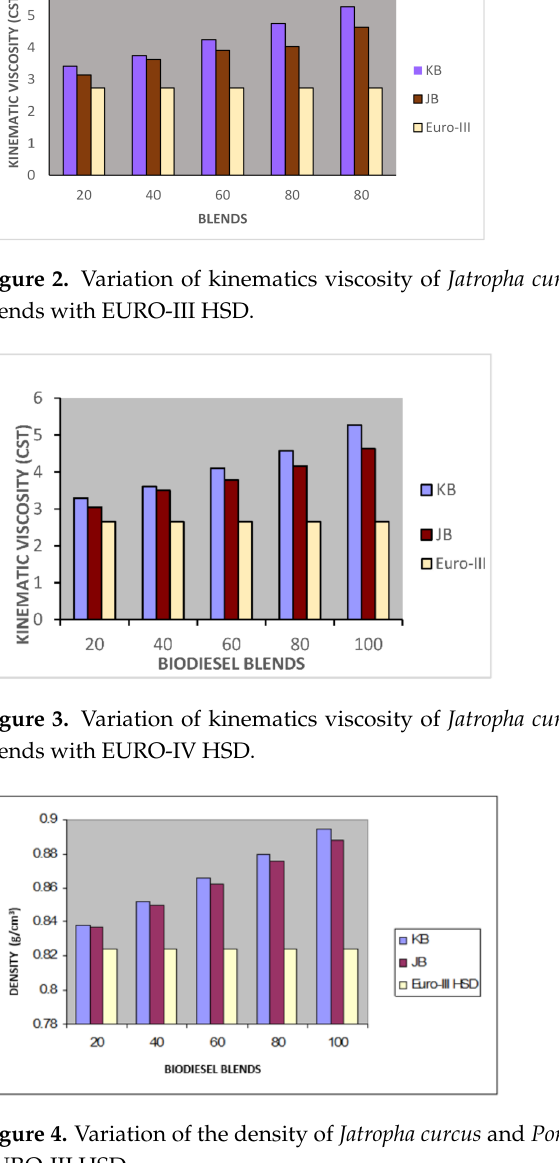
Figure 4. Variation of the density of Jatropha curcus and Pongamia pinnata methyl esters blends with EURO-III HSD.